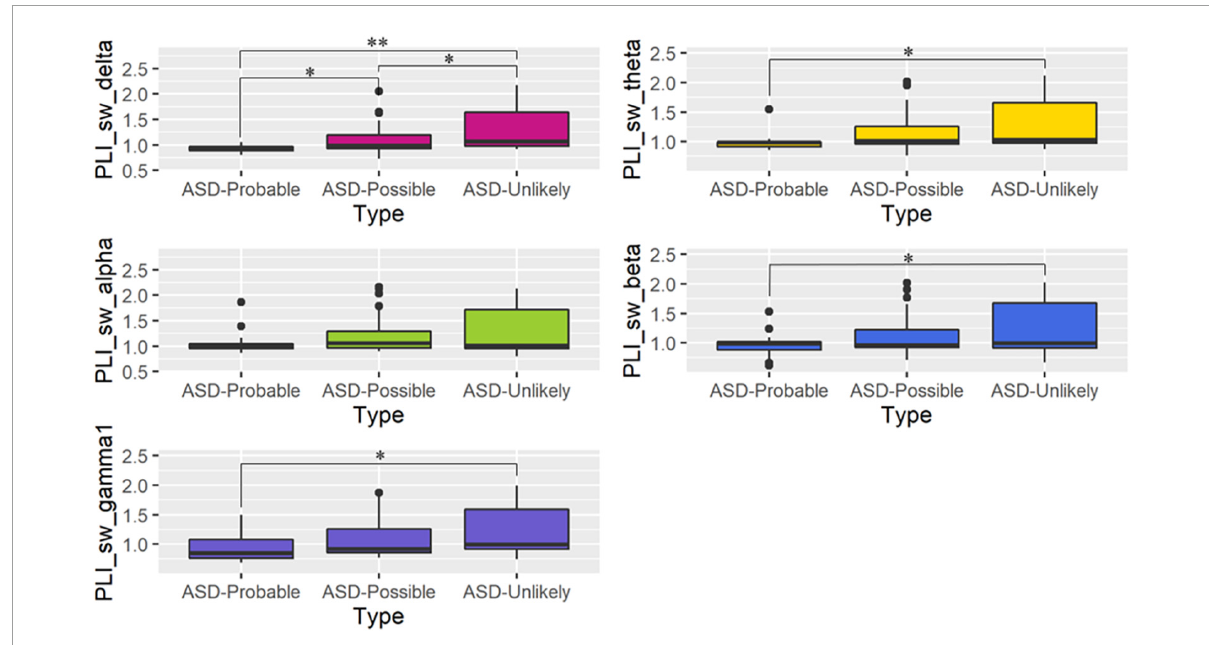
FIGURE1 Boxplot of small-worldness ( SW ) in each frequency band. The panels present the phase lag index values of SW among the three groups for each frequency band (mean ± SD). Post-hoc comparisons between the autism spectrum disorder (ASD)-Probable and ASD-Unlikely, ASD-Probable and ASD-Possible, and ASD-Possible and ASD-Unlikely groups: ∗ p < 0.05, ∗∗ p <